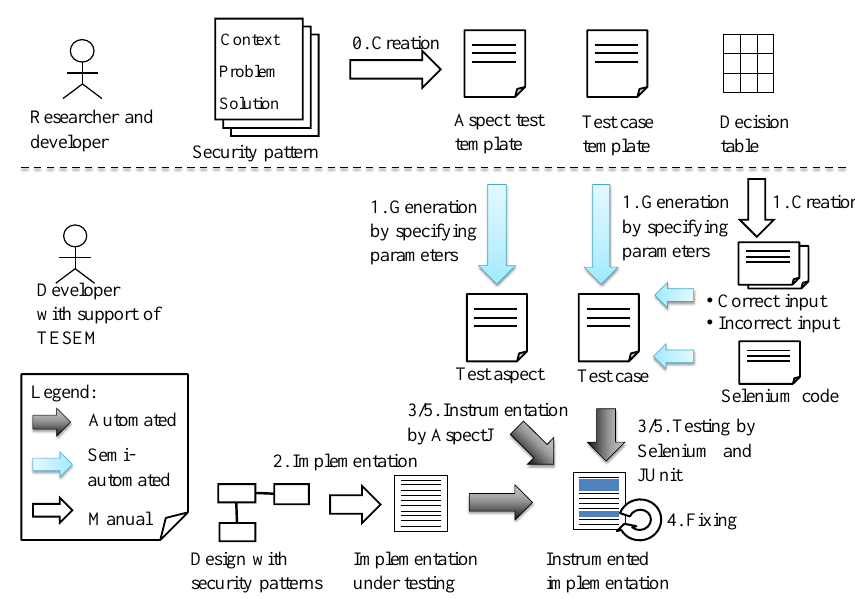
Figure 7. Process of our method.